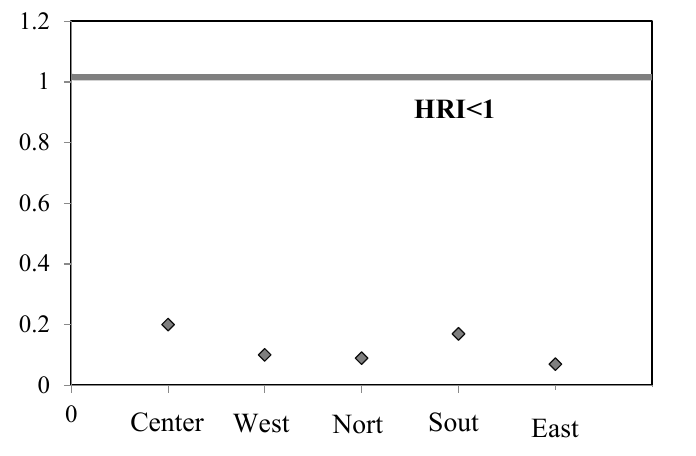
Figure 3. Health risk index (HRI) of diazinon residue in rice in each zone of the studied Figure 3. Health Risk Index (HRI) of diazinon residue in rice in each zone of the studied area